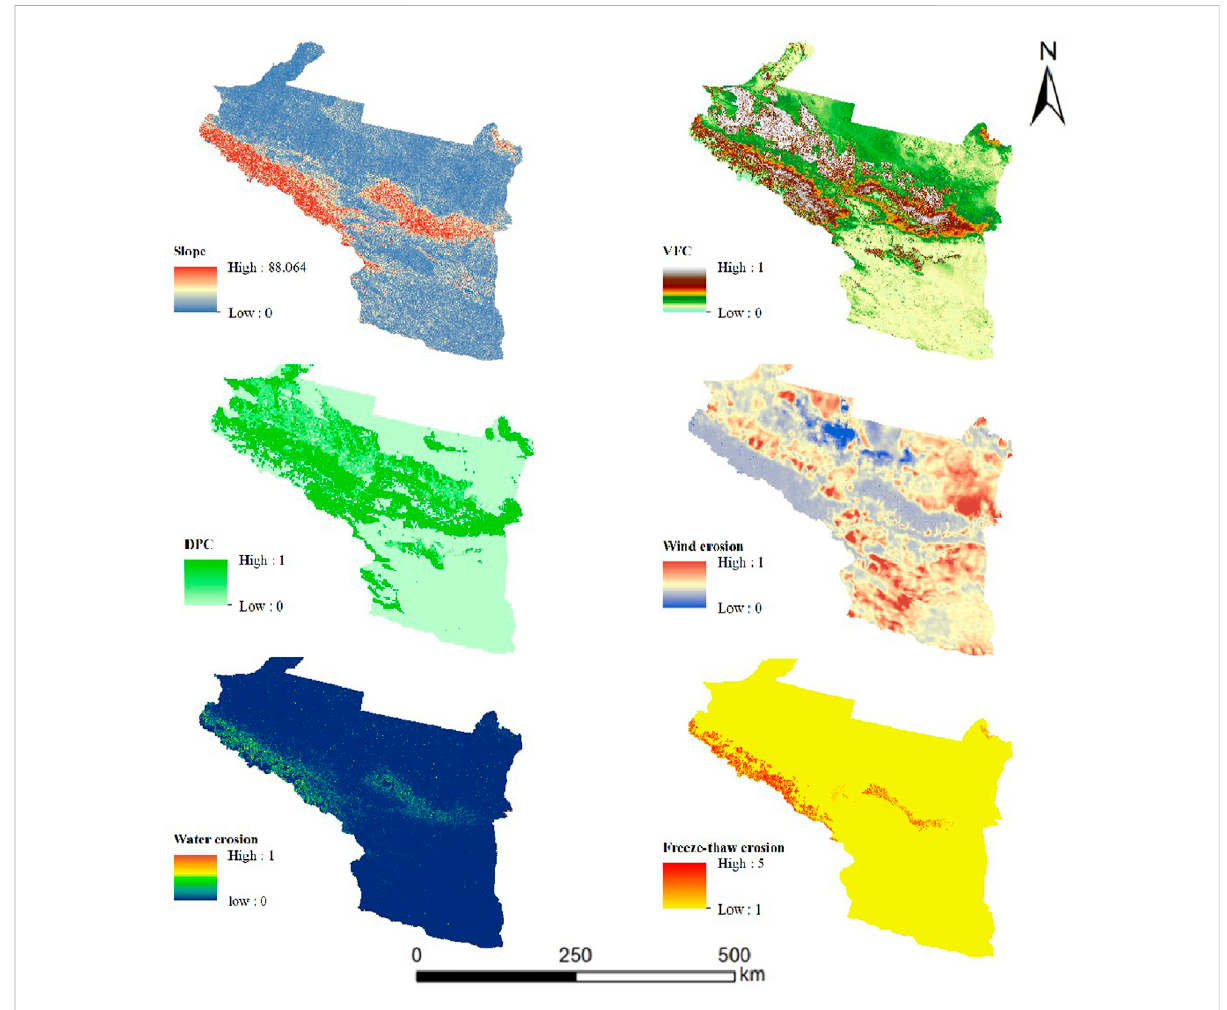
FIGURE 3 Spatial distribution of risk probability